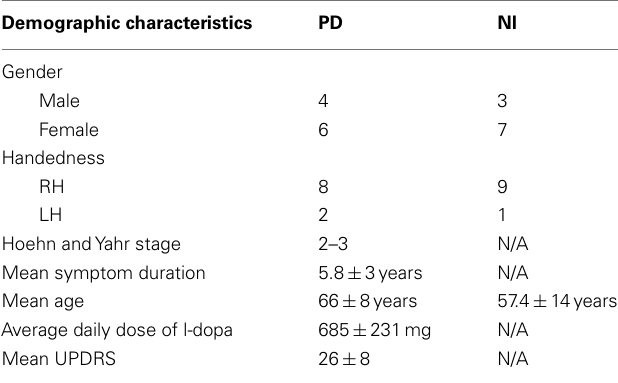
Table 1 | Demographic characteristics of PD patients and normal healthy